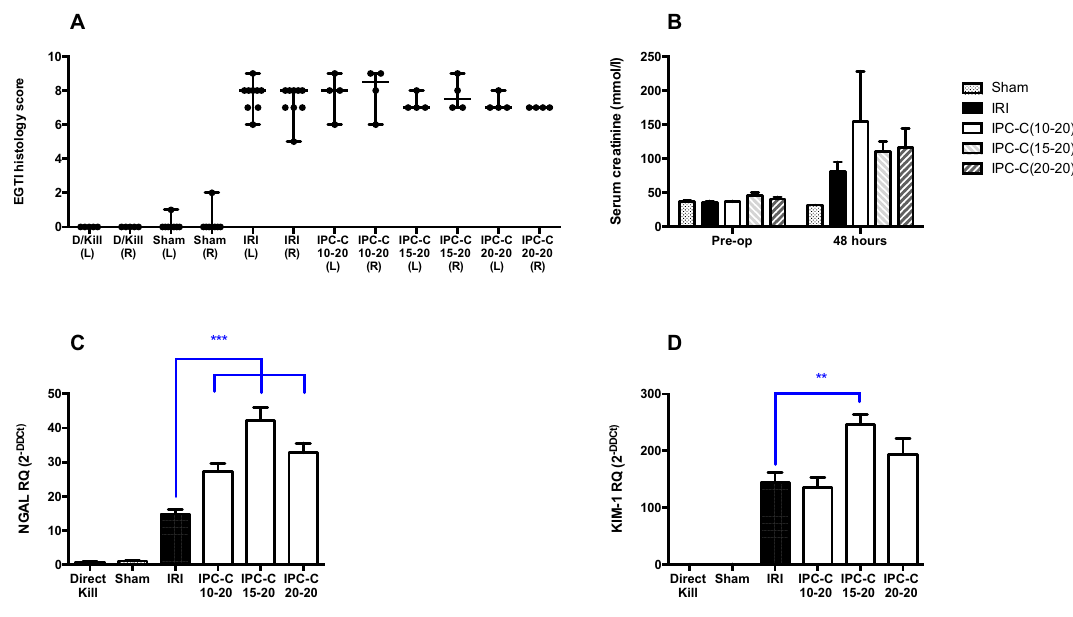
Figure 2. Effect of continuous IPC on EGTI score, serum creatinine and renal injury markers NGAL and KIM-1. (A) Renal cortex sections from Direct Kill, Sham, 45 min bilateral IRI, and 3 localized continuous IPC regimes (10, 15 and 20 min ischaemia and 20 min reperfusion (IPC-C 10–20, IPC-C 15–20, and IPC-C 20–20 respectively) prior to IRI, in rats at 48 h after reperfusion, were stained with H&E and scored for Endothelial, Glomerular, Tubular, and Interstitial cell damage. EGTI Histology scores are plotted as median and range. (B) Serum creatinine was measured pre-op and at 48 h and is plotted as mean ± SEM. (C,D) RT-qPCR analysis of NGAL and KIM-1 was performed following RNA extraction from whole kidney tissue. Expression is normalized to GAPDH and plotted as mean ± SEM. Numbers of animals in each group: Direct Kill (n = 5), Sham (n = 8), IRI (n = 9), IPC-C 10–20 (n = 4), IPC-C 15–20 (n = 4), and IPC-C 20–20 (n = 4). Statistical significance: *p < 0.05, **p < 0.01, ***p <